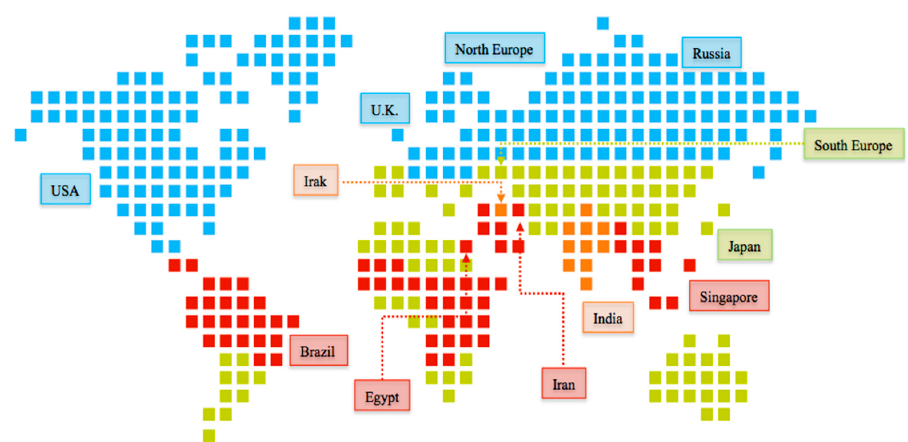
Figure 3. ICH climatic zones. Key: climate zone I (blue color), climate zone II (green color), climate zone III (orange color) and climate zone IVa and IVB (red color).